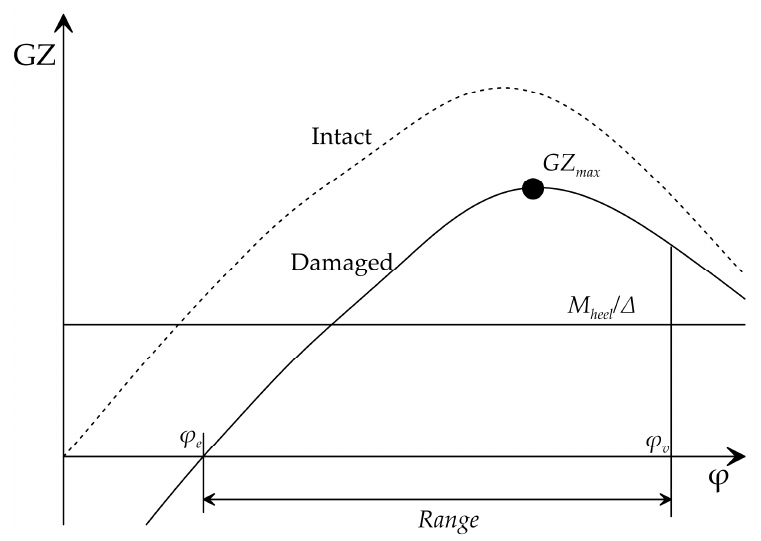
Figure 1. Residual GZ curve for static damage stability calculations.